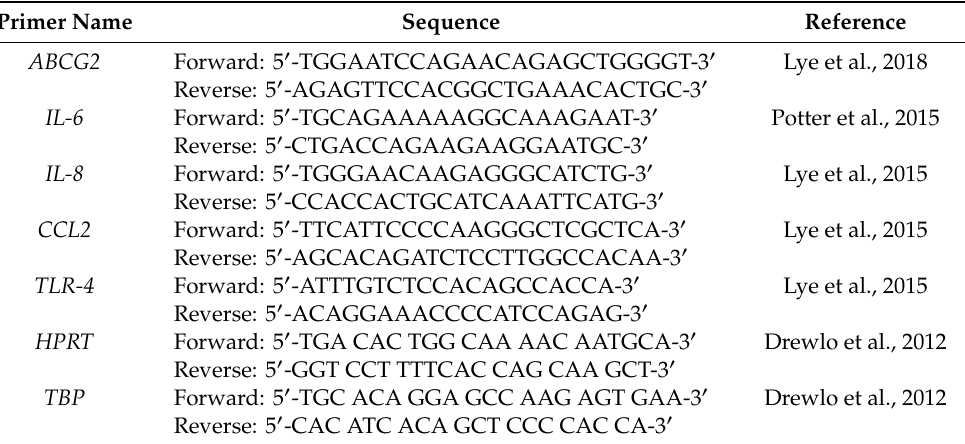
Table 1. List of primers used in this